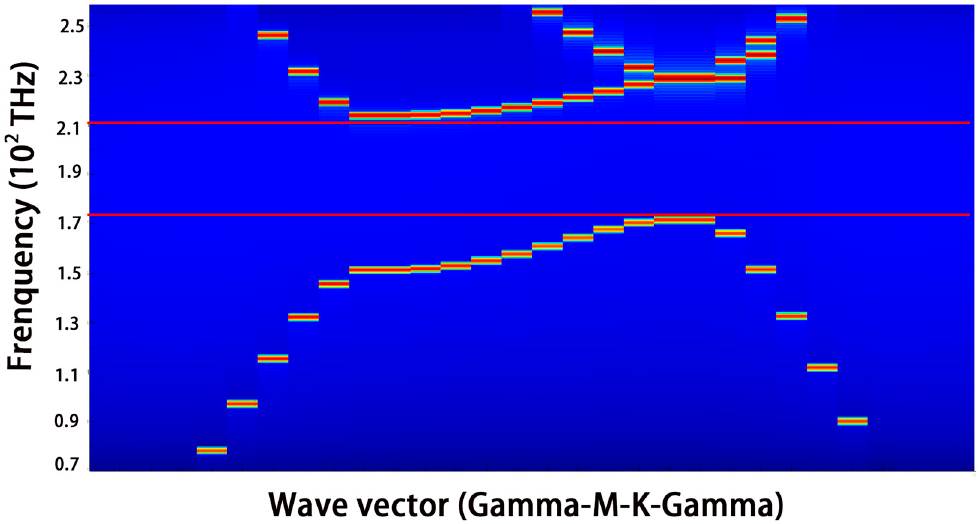
Figure 2. The photonic band gap of the complete PhC.